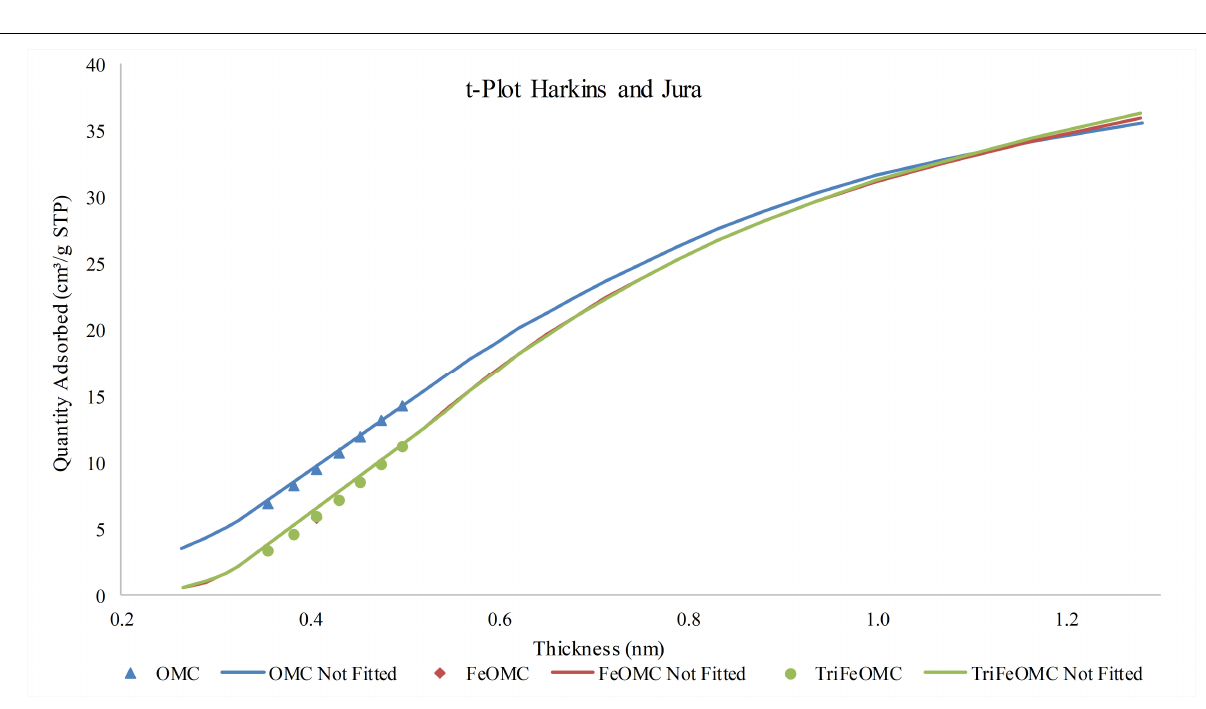
Frontiers in Materials |